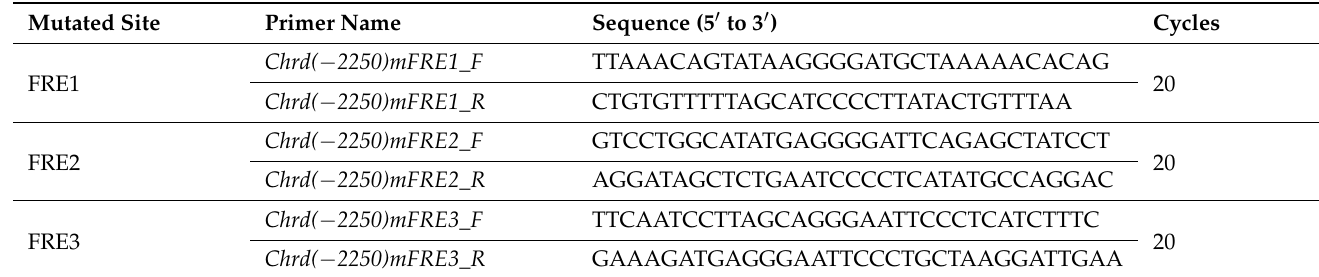
Table 4. Primers used for site-directed